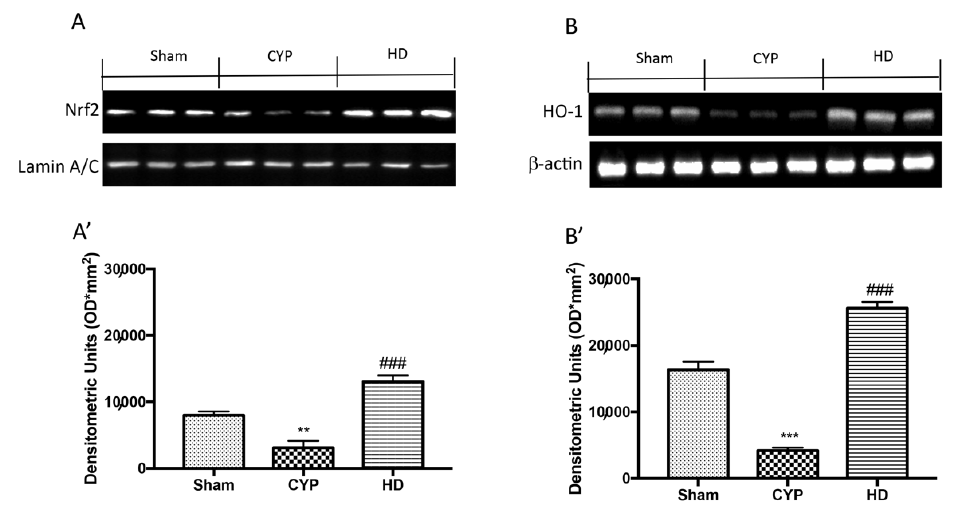
Figure 2. Effect of HD on Nrf2 and HO-1 expression in bladder after repeated CYP injections. Western blot analysis showed that Nrf2 expression was significantly decreased in the CYP group, while treatment with HD increased the expression of Nrf2 ( A , A’ ). HO-1 expression was decreased after repeated CYP injections; treatment with HD increased levels of this protein ( B , B’ ). Values are means ± SD of five animals for each group; ** p < 0.01 vs. Sham; *** p < 0.001 vs. Sham; ### p < 0.001 vs. CYP.